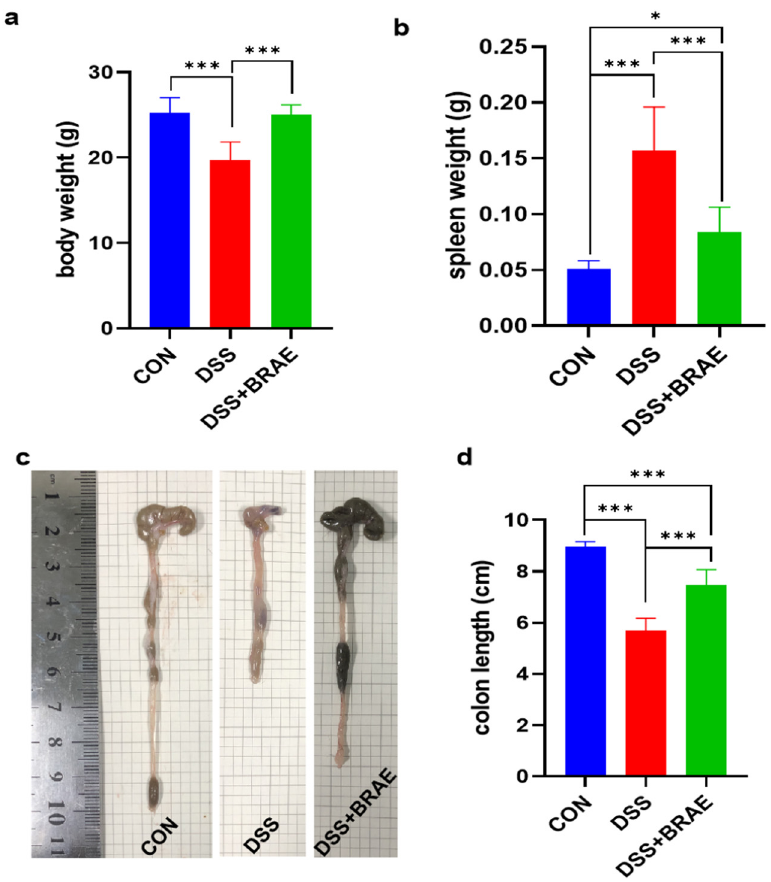
Figure 3: BRAE improves the symptoms of DSS - induced colitis in mice. ( a ) Body weight in di ff erent groups, ( b ) spleen weight in di ff erent groups, ( c ) macroscopic observations of colon, and ( d ) colon length. Data represent mean ± SD ( n = 10 ) . * P < 0.05, *** P < 0.001.